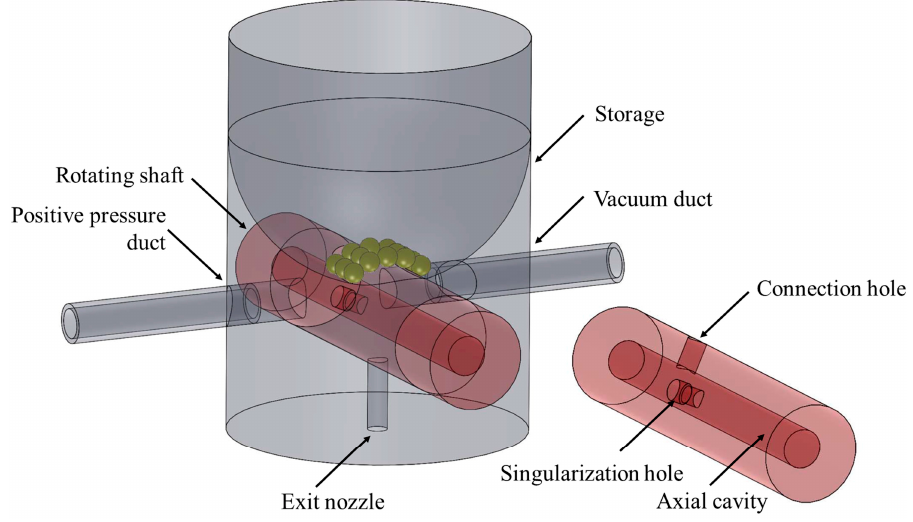
Figure 2. The innovative singularization mechanism.